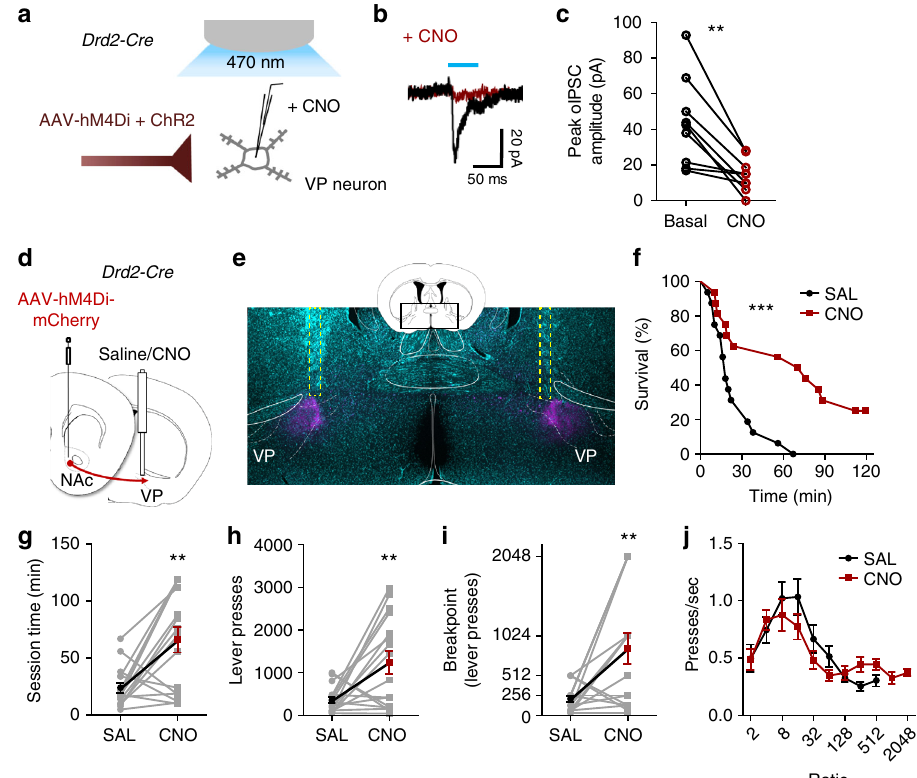
Fig. 6 DREADD-mediated silencing of D2-MSN terminals in the VP enhances motivation. a Schematic illustrating oIPSC recording from VP neurons in slice following CNO (10 µ M) treatment and blue-light stimulation of terminal fi elds from NAc MSNs co-expressing ChR2 and hM4Di. b Representative average oIPSC traces following 50-ms light stimulation under basal conditions (black) and after CNO application (dark red). c CNO signi fi cantly reduced oIPSC amplitude from baseline (14.5 ± 3.1 from 43.6 ± 8.3 pA; ** p < 0.005, paired Student ’ s t -test, n = 9 (6) cells). d Drd2-Cre mice were injected hM4Di-mCherry AAV into the NAc, and a bilateral microinfusion cannula guide was implanted. Four weeks after surgery, an internal cannula was brie fl y inserted into the guide to deliver CNO (1 mM, 0.3 µ l/side) or saline to the caudal VP prior to PR testing. All 16 mice received both treatments on different days in counterbalanced fashion. e Representative fl uorescent Nissl stain (green) showing the location of bilateral microinfusion cannula tracks (yellow dotted lines) relative to hM4Di-mCherry immuno fl uorescent terminal fi elds (red) in the caudal aspect of the VP. Inset, coronal atlas plane ( + 0.02 mm relative to Bregma) from which image was acquired. f , g Signi fi cant enhancing effect of CNO microinfusion on session duration plotted as a survival function or as total session time ( n = 16 mice/condition). h , i Lever presses and breakpoint were signi fi cantly increased after CNO ( n = 16 mice/condition). j Press rate as a function of ratio requirement was not altered by CNO. Error bars =